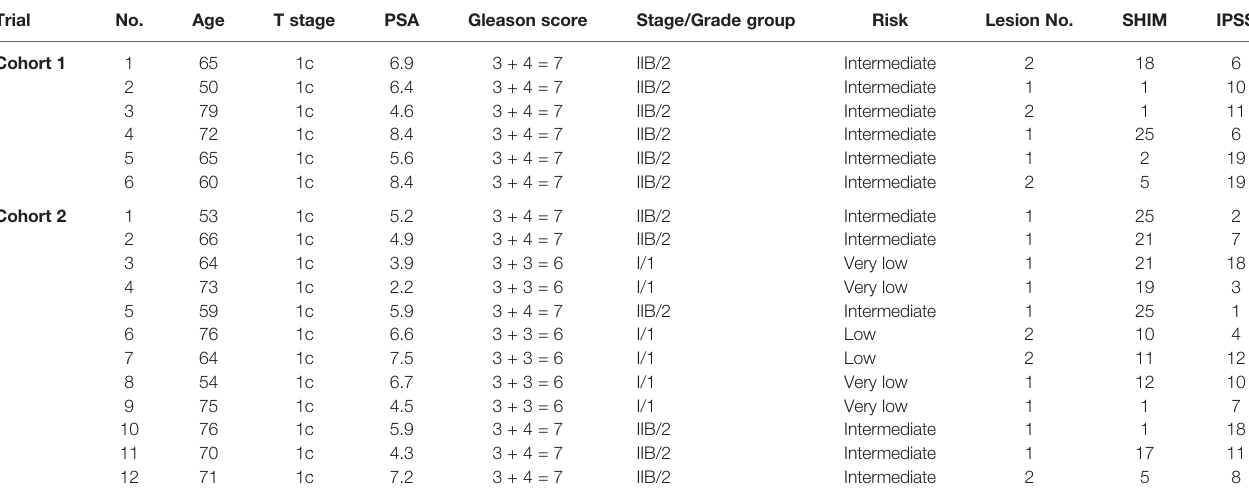
TABLE 1 | Descriptive patient